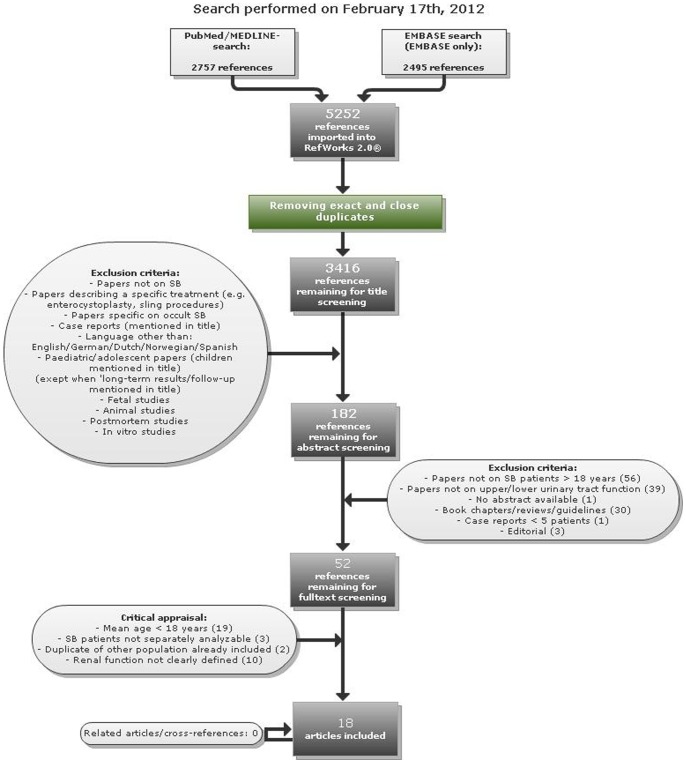
Search strategy and selection.The database search was performed on February 17 2012. For more details on the search strategy see the Materials and Methods section.